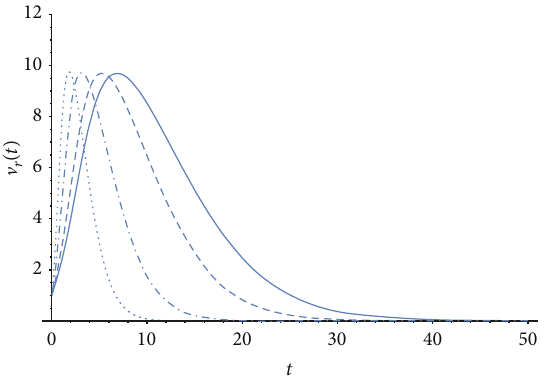
Figure 5: The graph represents the solution behavior for the variable v t (concentration of recombinant virus) versus time t r under di ff erent values of the order of the derivative. The solid line, dashed line, dot-dashed line, and dotted line represent solution behavior at ζ = 1, ζ = 0 95, ζ = 0 85 , and ζ = 0 75 ,